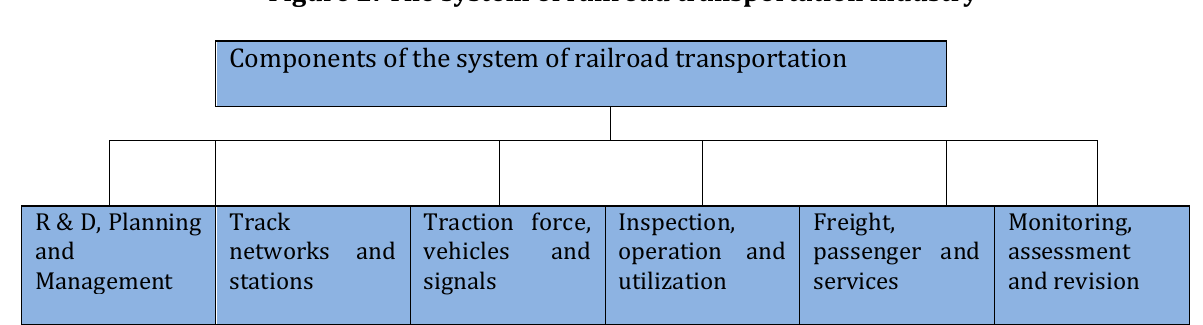
Figure 2: The system of railroad transportation industry